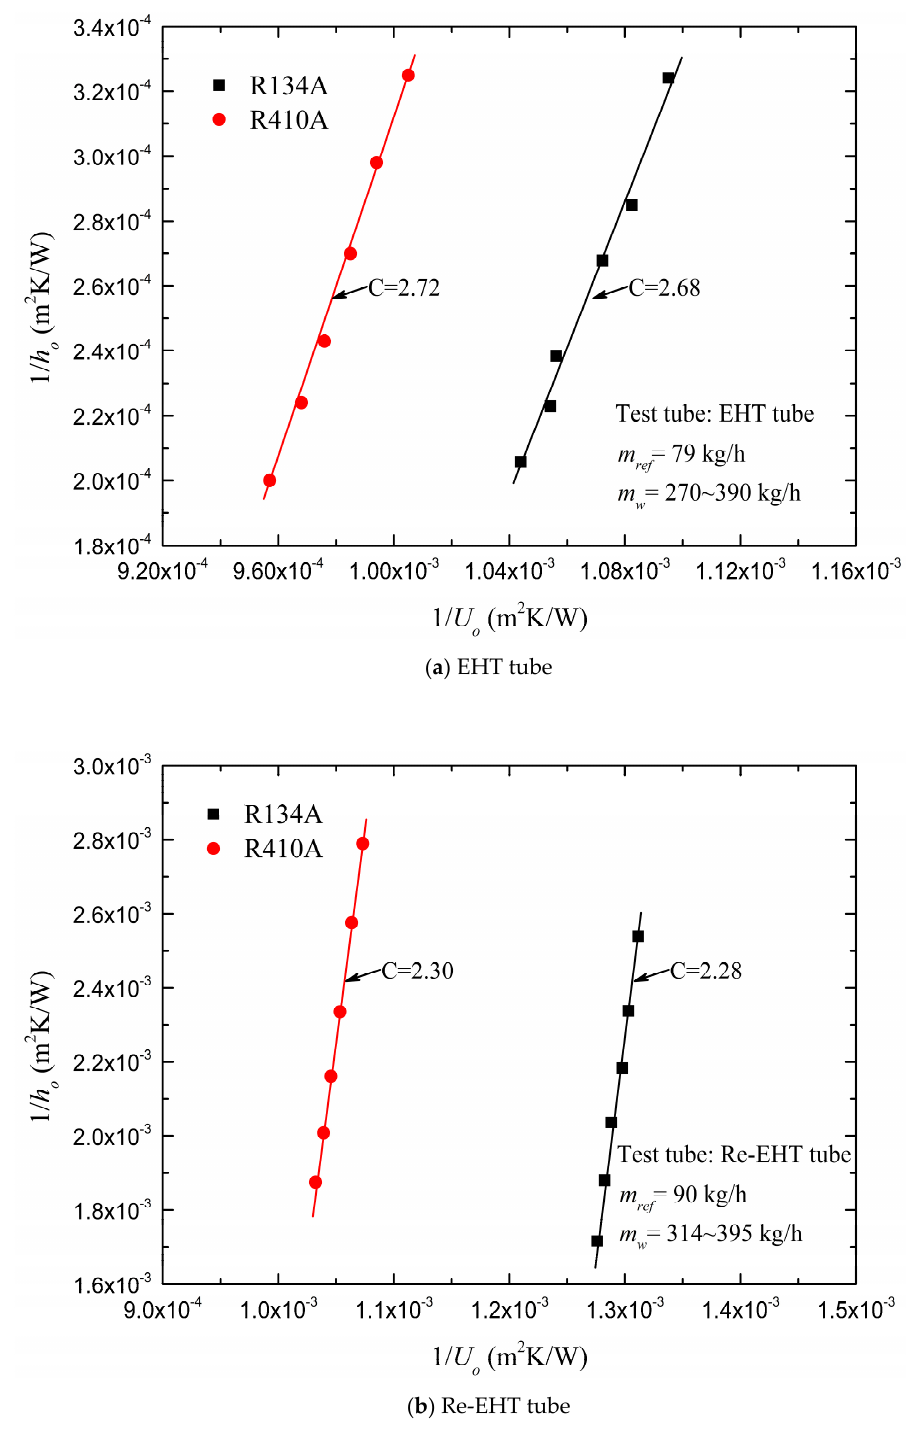
Figure 4. Test results of Wilson plot [23] of the ( a ) EHT tube and ( b ) Re-EHT tube.